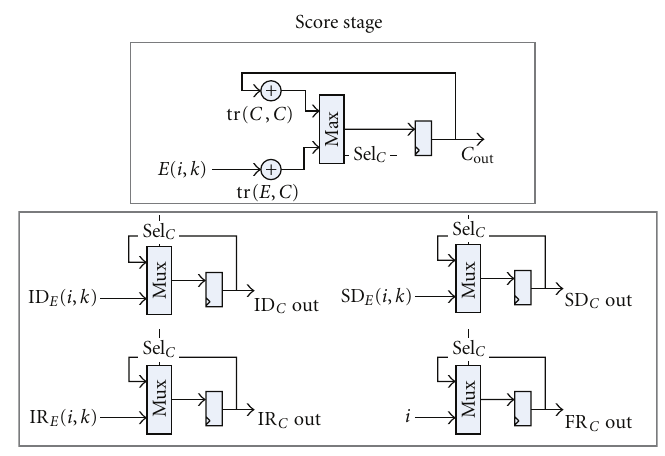
Figure 13: C vector calculation